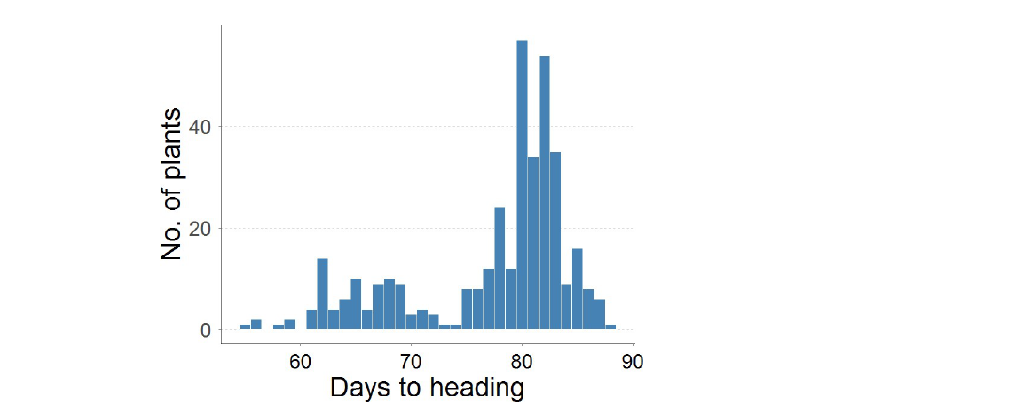
Fig 2. Distribution of days to heading of an F 2 population derived from a cross between Gleva and G123 .